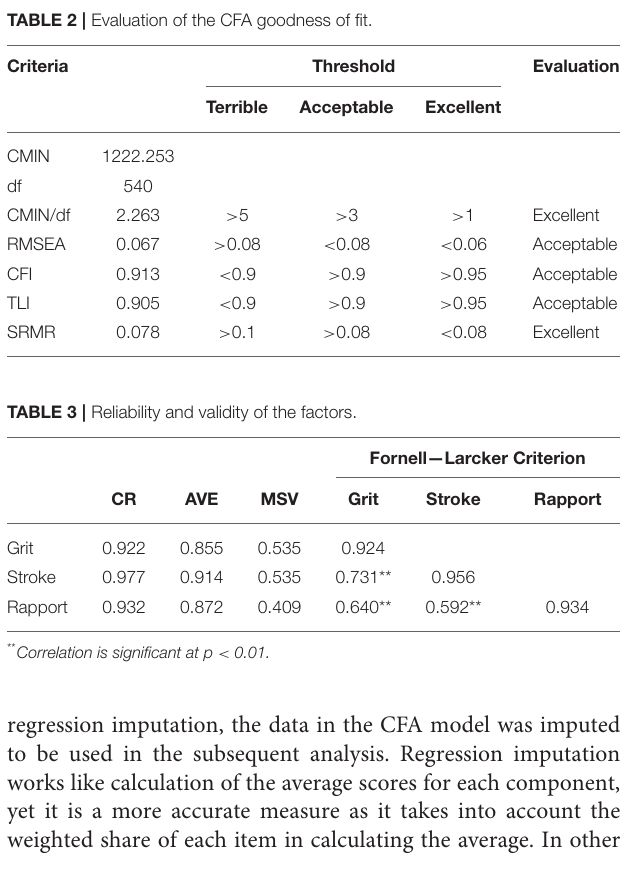
TABLE 2 | Evaluation of the CFA goodness of fit.